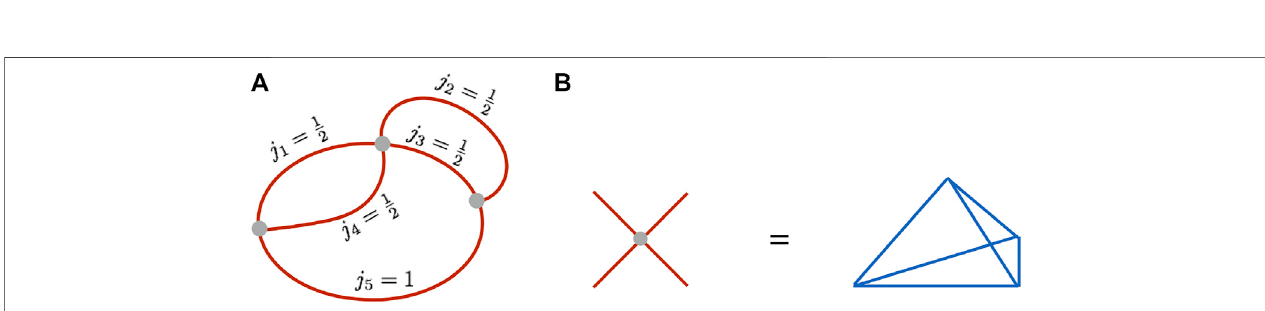
FIGURE 2 | Three different representations of the structure of couplings between eight q i qubits forming an elementary block of the D-Wave processor: (A) The physical representation of quibits as closed superconducting loops. The couplers between the qubits are represented by triangles. (B) The Chimera graph structure of couplings between the eight qubits. (C) Representation of a single block which is useful when interconnections in the array of blocks are considered.